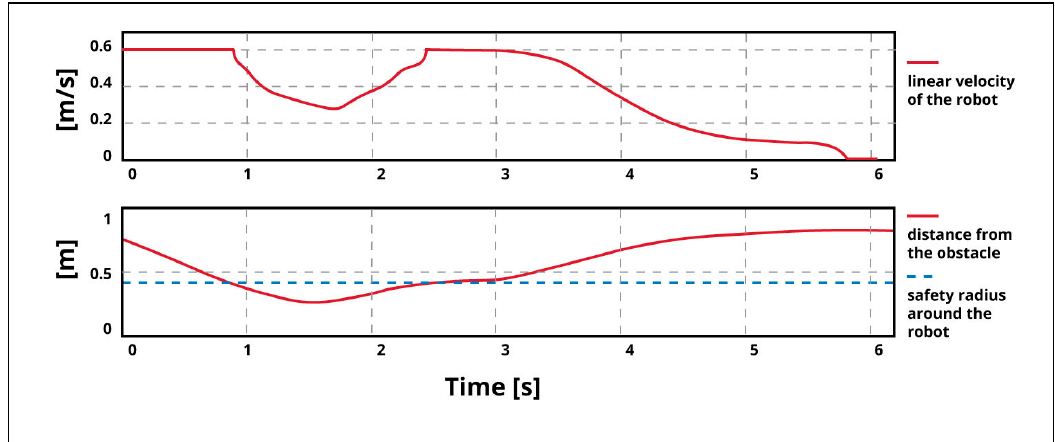
Figure 15. Linear velocity of the robot and its variations, depending on the distance separating the robot from the obstacle.